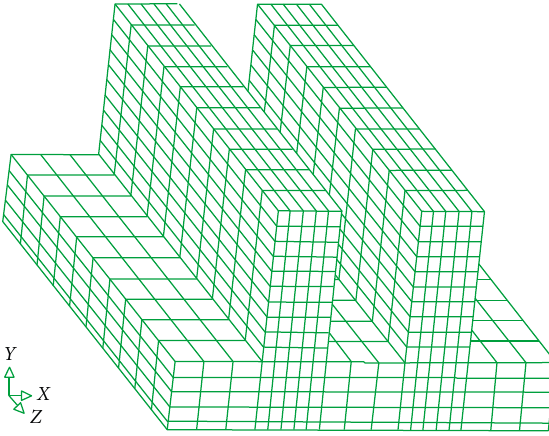
Figure 4: Finite element model of the double-wall Table 2: Thermal properties of SV40 and low-heat concretes.